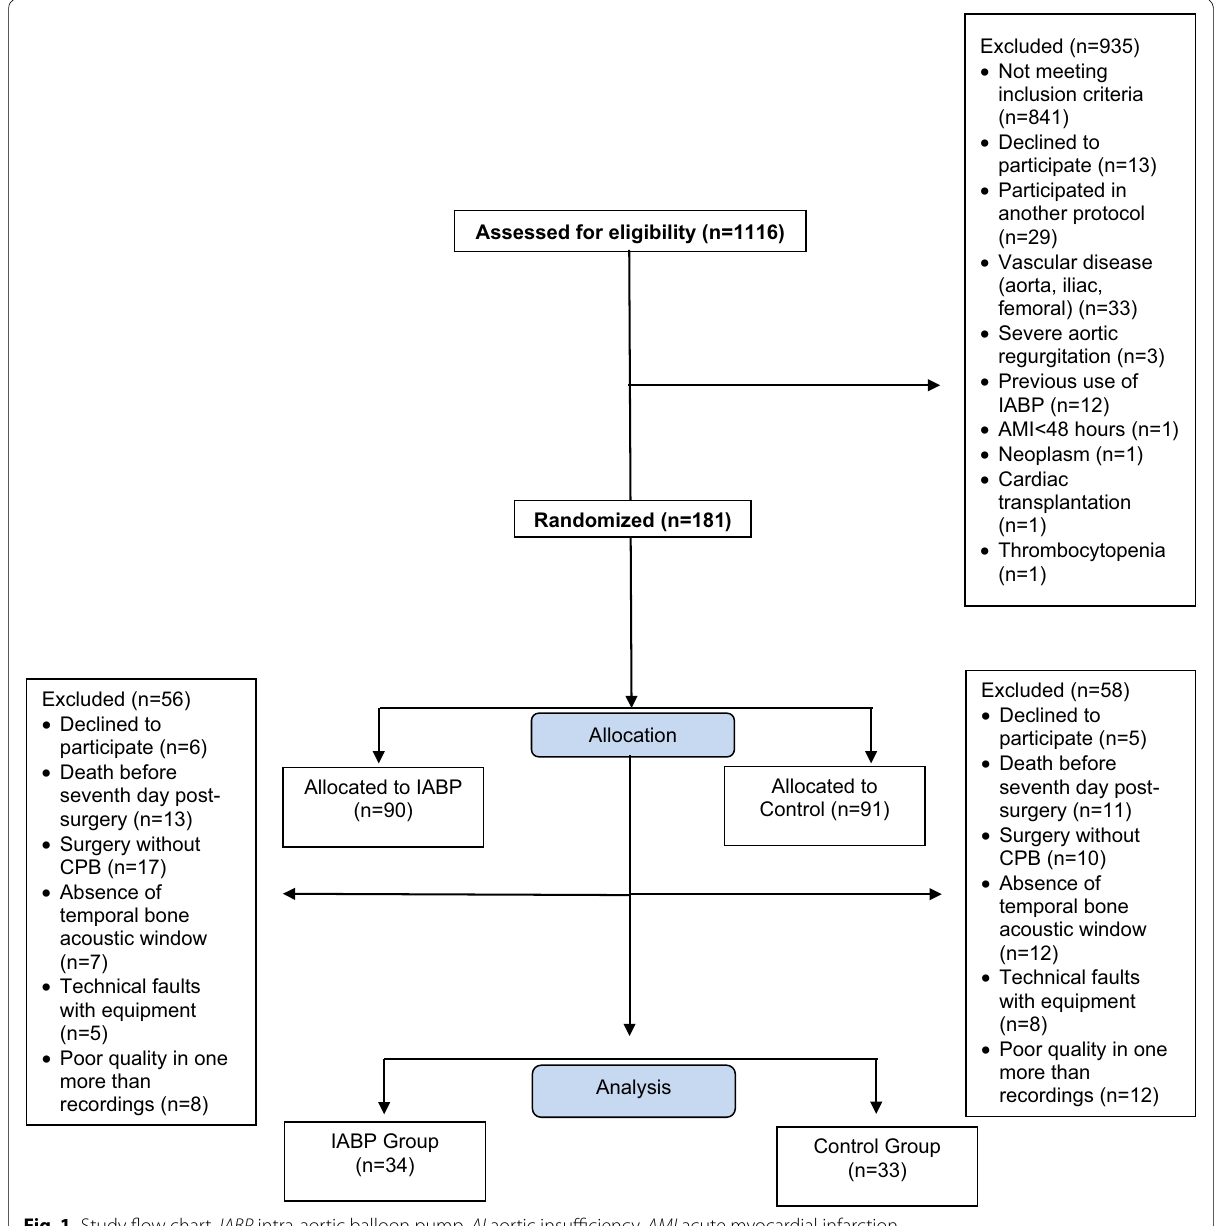
Fig. 1 Study flow chart. IABP intra‑aortic balloon pump, AI aortic insufficiency, AMI acute myocardial